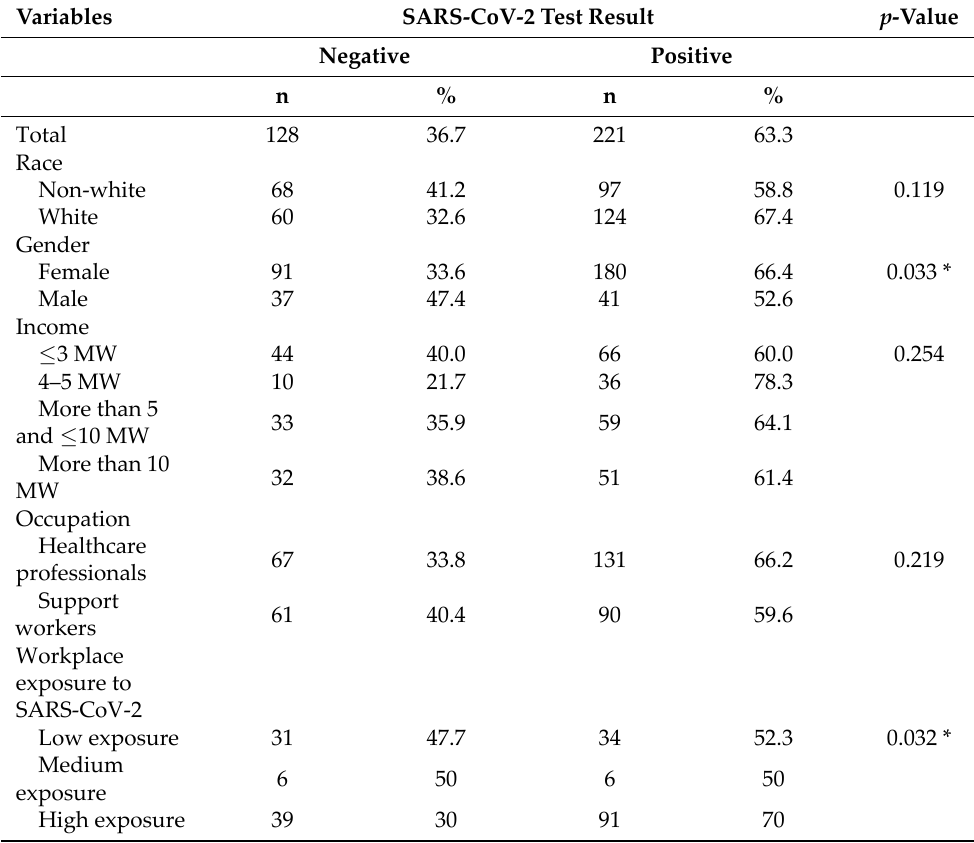
Table 5. Socio‑demographic variables and types of work activities of IFF/Fiocruz healthcare workers, according to SARS‑CoV‑2 test